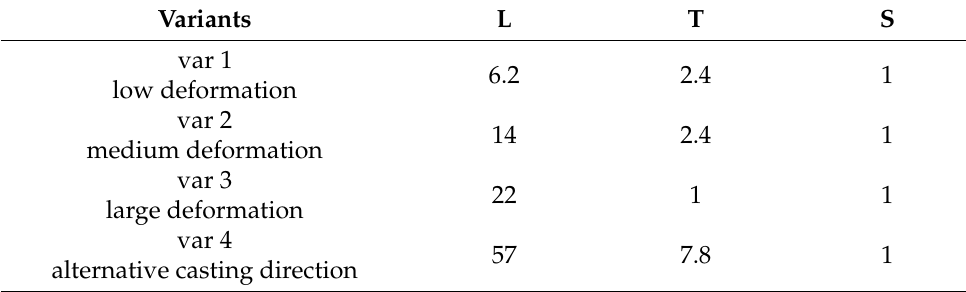
Table 2. Estimation of aspect ratio of forged AA7010-T7452 variants var 1–var